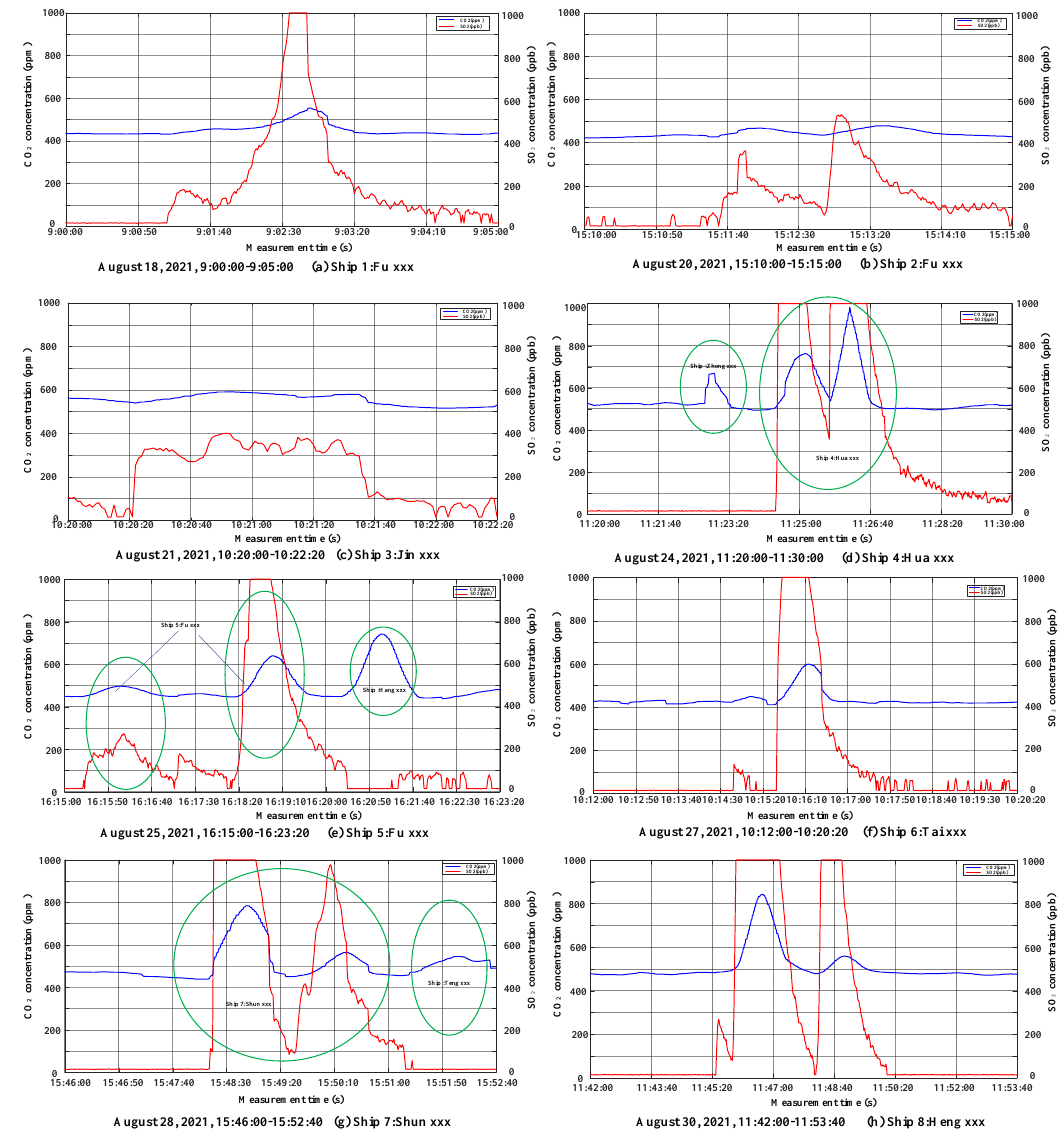
Figure 7. Monitoring curve of excessive sulfur content in ship fuel. To fully verify the accuracy of the sensor, we provided the comparison results be- tween the measured value and the true value of FSC of eight ships. The true value of FSC is obtained through laboratory testing. The data are shown in Table 3.